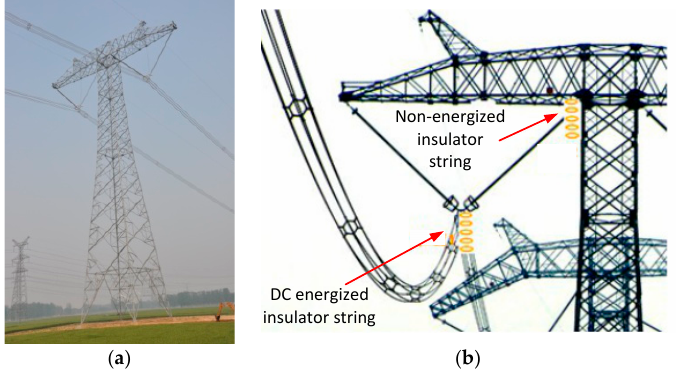
Figure 6. Field pollution test of transmission line operating insulators. ( a ) The ±800 kV transmission line view; ( b ) Diagram of the insulator string samples’ arrangement.